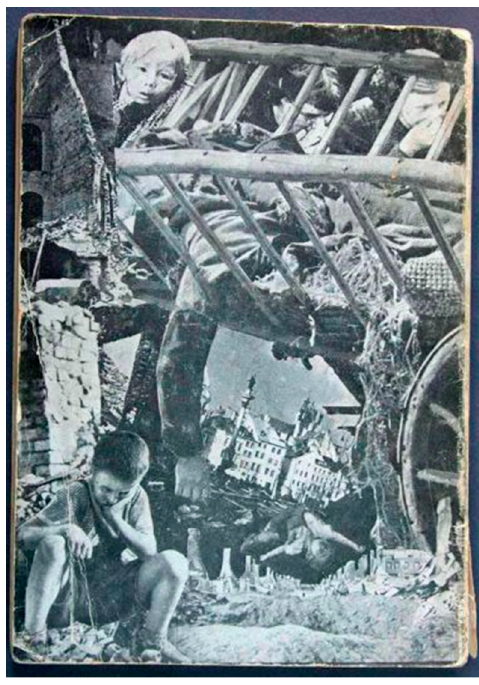
Figure 5. Teresa ˙Zarnower. Obrona Warszawy (Defense of Warsaw) (1942), photomontage (back cover of book), courtesy of On Paper Store, Italy.